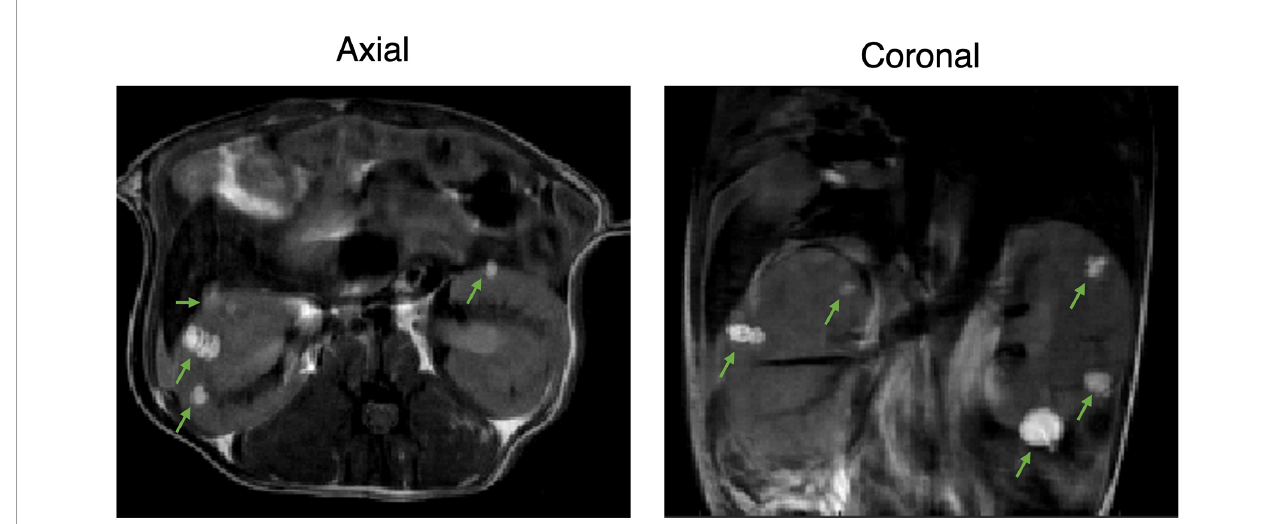
FIGURE 1 | Two-dimensional proton imaging of 6 – 7-month-old Tsc2 +/- A/J male mice. Representative 2D T 2 -weighted images of the TSC mice with bilateral adenomas and cystic lesions in the renal capsule and pelvis at axial and coronal orientation. Lesions are indicated with green